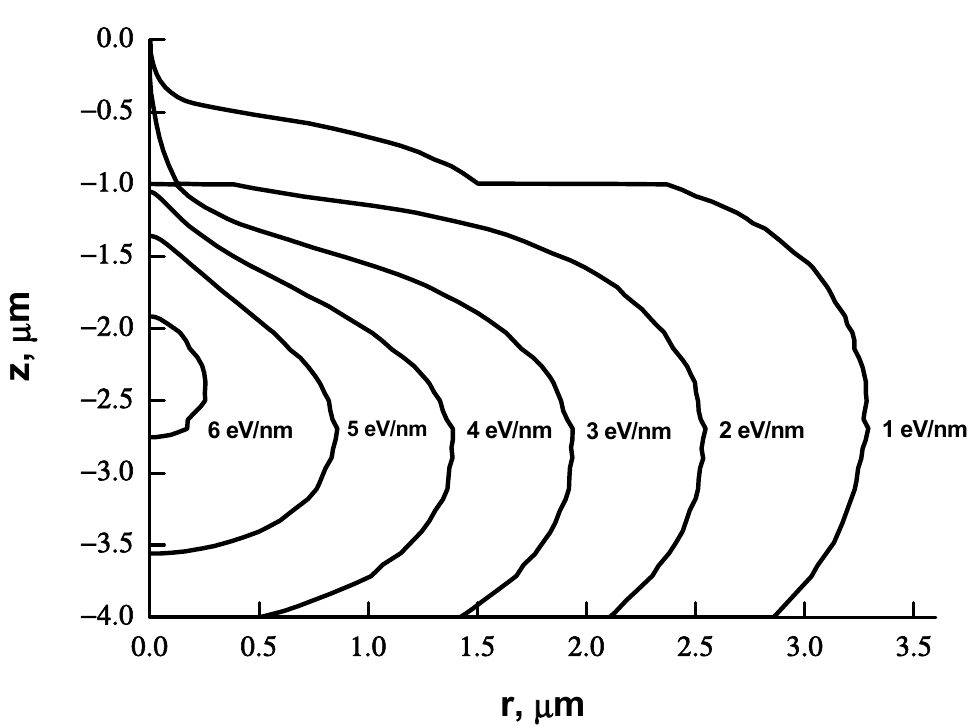
Figure 1. The results of the Monte Carlo calculation of the integral density of the absorbed energy G r ( r , z ). The values of the iso-levels of the density of the absorbed energy: 1, 2, 3, . . . eV/nm. The resist film thickness (PMMA) is 1 micron. The substrate is Si (300 µ m). The initial energy of electrons is 25 keV. The number of trajectories considered is 200,000.